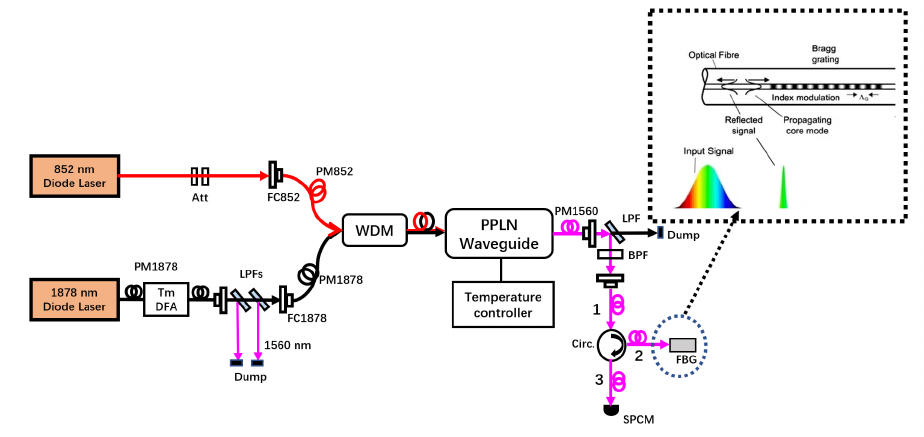
Figure 5. Diagram of experimental device. TmDFA, thulium-doped fiber amplifier; att., attenuator; LPF, long wavelength pass filter; WDM, wavelength division multiplexing; BPF, 1560-nm band-pass filter; Circ., fiber circulator; FBG, fiber Bragg grating filter; SPCM, single-photon counting module.